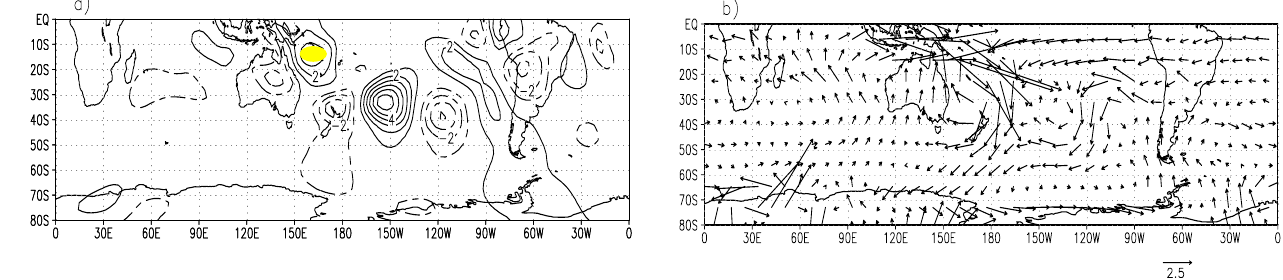
Figure 2 Fig. 2. (a) Meridional wind component anomalies (ms − 1 ) on day 10 of integration at 250hPa and (b) wind vector anomaly at 850hPa, corresponding to the + σ basic state experiment with the forcing at 170 ◦ E–15 ◦